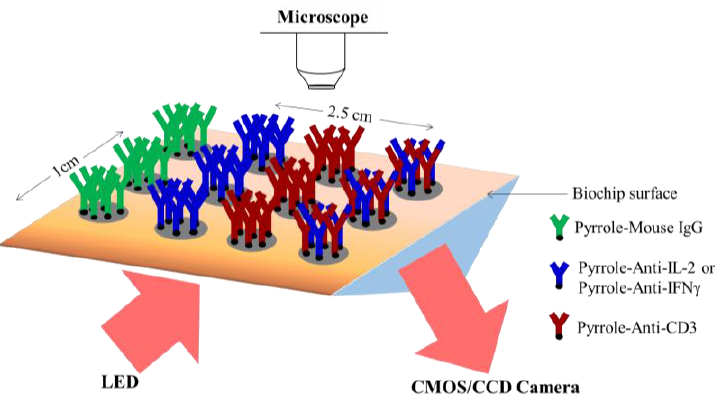
Figure 1. General scheme describing the design of the biochip for the capture of T-cell and the detection of secreted cytokines. Pyrrole-conjugated cell- and cytokine-specific antibodies (Anti-CD3, anti-IL-2 or anti-IFN-γ, and Mouse IgG as negative isotypic control) are electrochemically grafted side-by-side or mixed on the biochip surface (~300–400 µm of spot diameter). The grafted biochip is subsequently treated with Thiol-PEG to prevent nonspecific adhesion of cells on unfunctionalized regions across the biochip